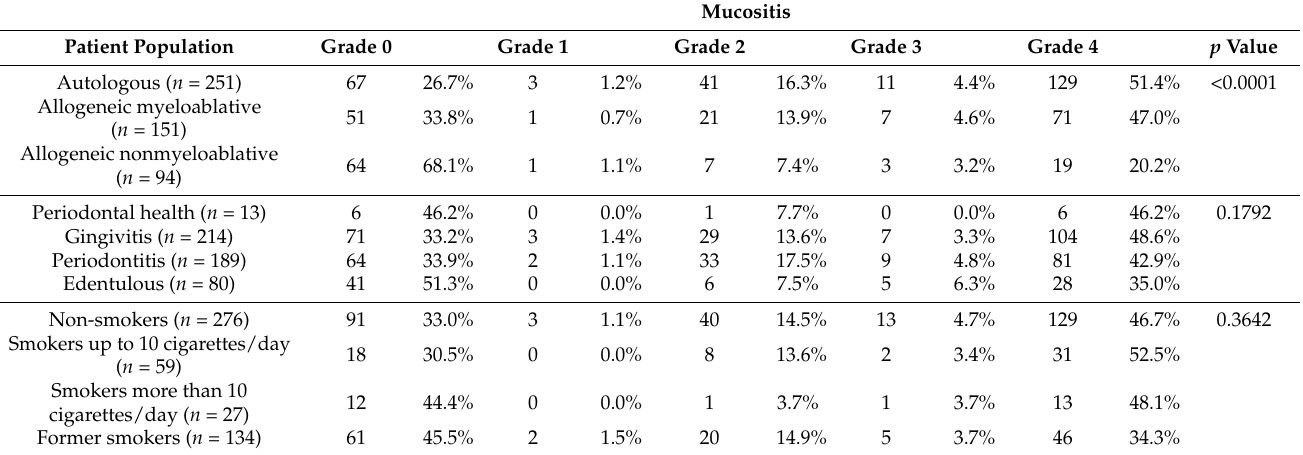
Table 3. Prevalence and severity of OM with regard to HSCT type, periodontal status, and smoking.